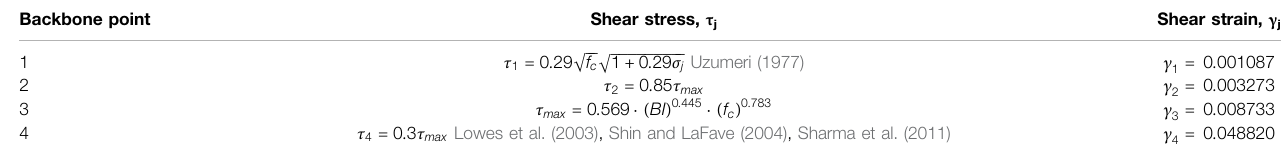
TABLE 7 | Shear stress and strain parameters of the proposed constitutive law. Backbone point